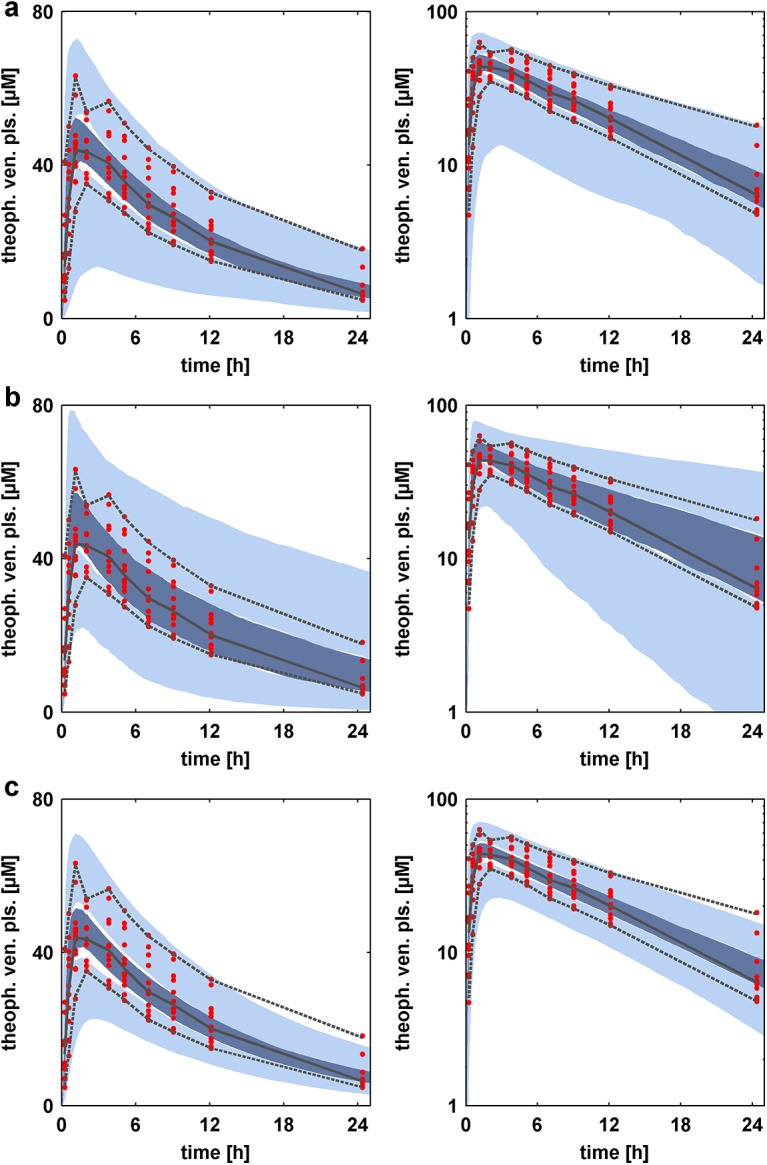
Comparison of visual predictive checks of population pharmacokinetics.(a) Visual predicive check (VPC) of the pharmacokinetic behavior using the posterior distributions based on the presented Bayesian population PBPK approach. The uncertainty in population parameters was included in the VPC. (b) Visual predicive check of the pharmacokinetic behavior using the prior distributions of all parameters. (c) Visual predicive check (VPC) of the pharmacokinetic behavior using the maximum posterior estimates of the posterior distribution based on the presented Bayesian population PBPK approach. Each VPC is presented in linear scale (left) and logarithmic scale (right). The VPCs were performed as described in the text. In each VPC, the 5% and 95% percentiles (black dotted lines) and the median (black line) of the experimental data (red dots) are compared against the 95% confidence intervals of the 5% and 95% percentile of the simulation (light blue area) and the median (blue area).